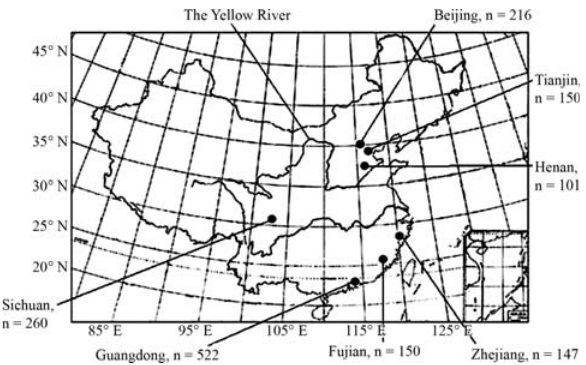
Figure 1 - Geographical location of the seven populations in